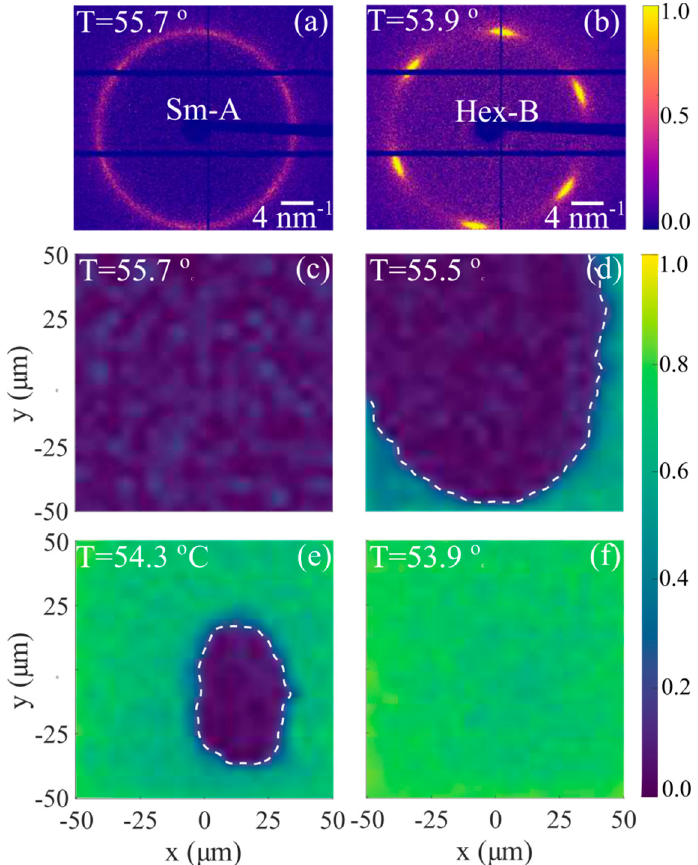
Figure 9. Coexistence of the smectic-A (Sm-A) and stacked hexatic (Hex-B) phases in a 54COOBC compound. ( a,b ) Examples of the in-plane diffraction from the Sm-A phase ( a ) and Hex-B phase ( b ); ( c – f ) spatially resolved maps of the BO order parameter C 6 . The color code indicates the normalized intensity of the scattered X-rays. The white dashed line in ( d , e ) separates regions of Sm-A (blue) and Hex-B (green) phases. (adopted from Zaluzhnyy et al. [70]). Reproduced with permission of American Physical Society.